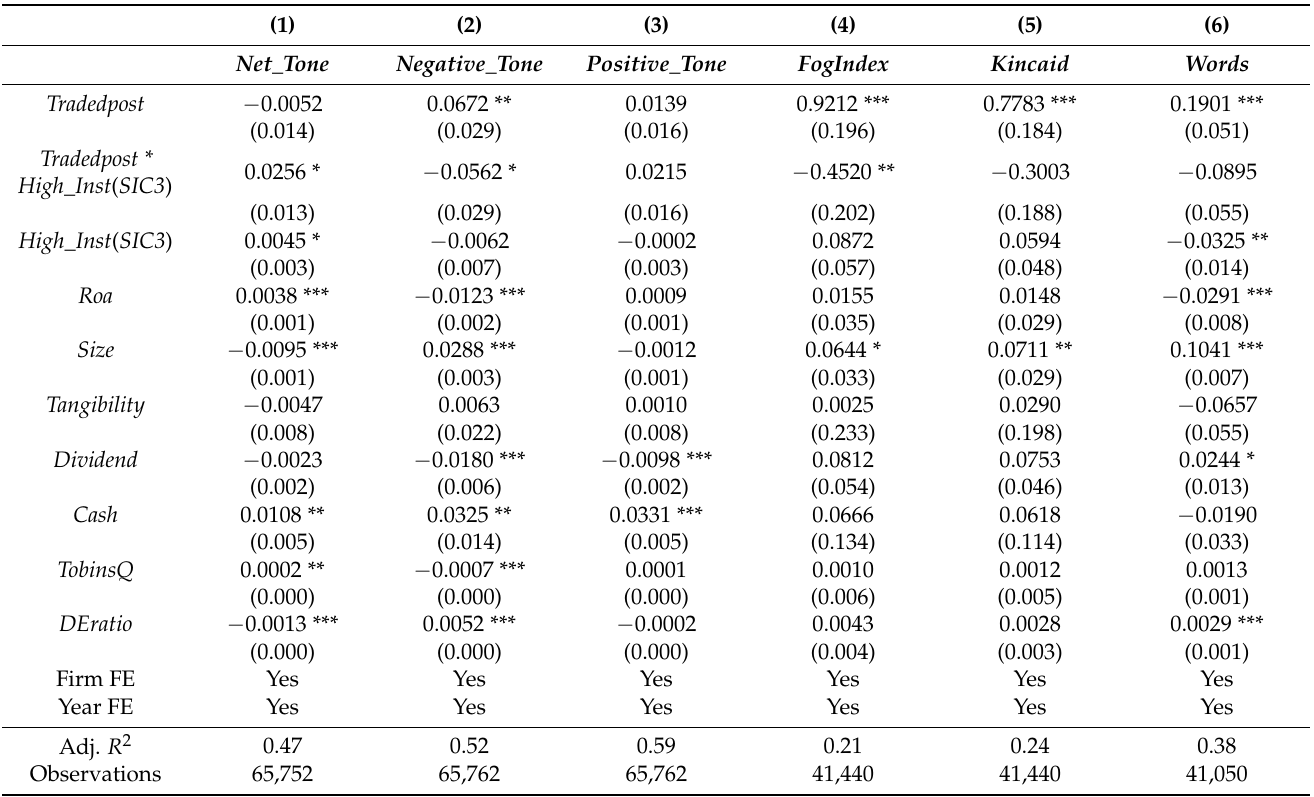
Table 8. Disclosure under high institutional ownership. This table reassesses the results from Tables 6 and 7 after including institutional presence (i.e., High_Inst ( SIC3 )). Standard errors were clustered by firms and reported in parentheses. Lagged firm-specific controls and firm and year fixed effects are included in all specifications. Coefficients with *, **, or *** indicate a significance level of 0.10, 0.05, or 0.01, respectively. For detailed definitions of variables, please refer to Appendix A Table